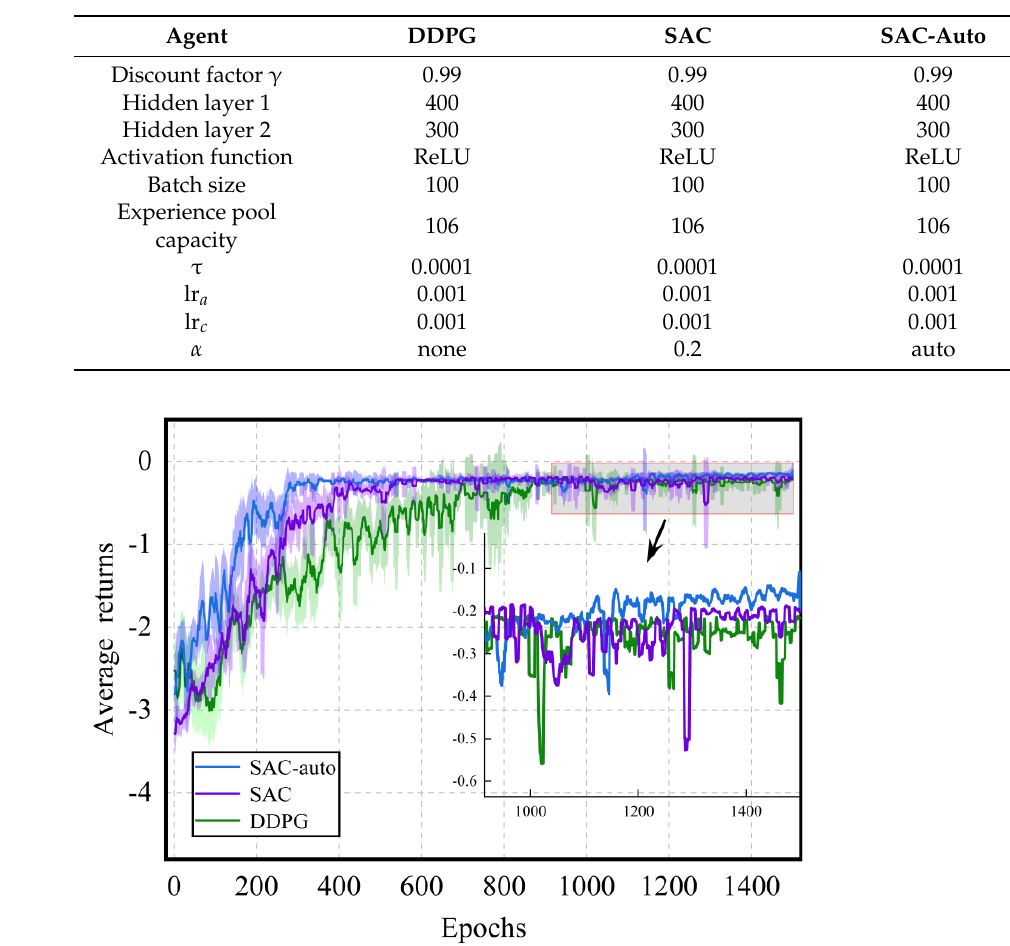
Table 3. Hyperparameters of the algorithms.